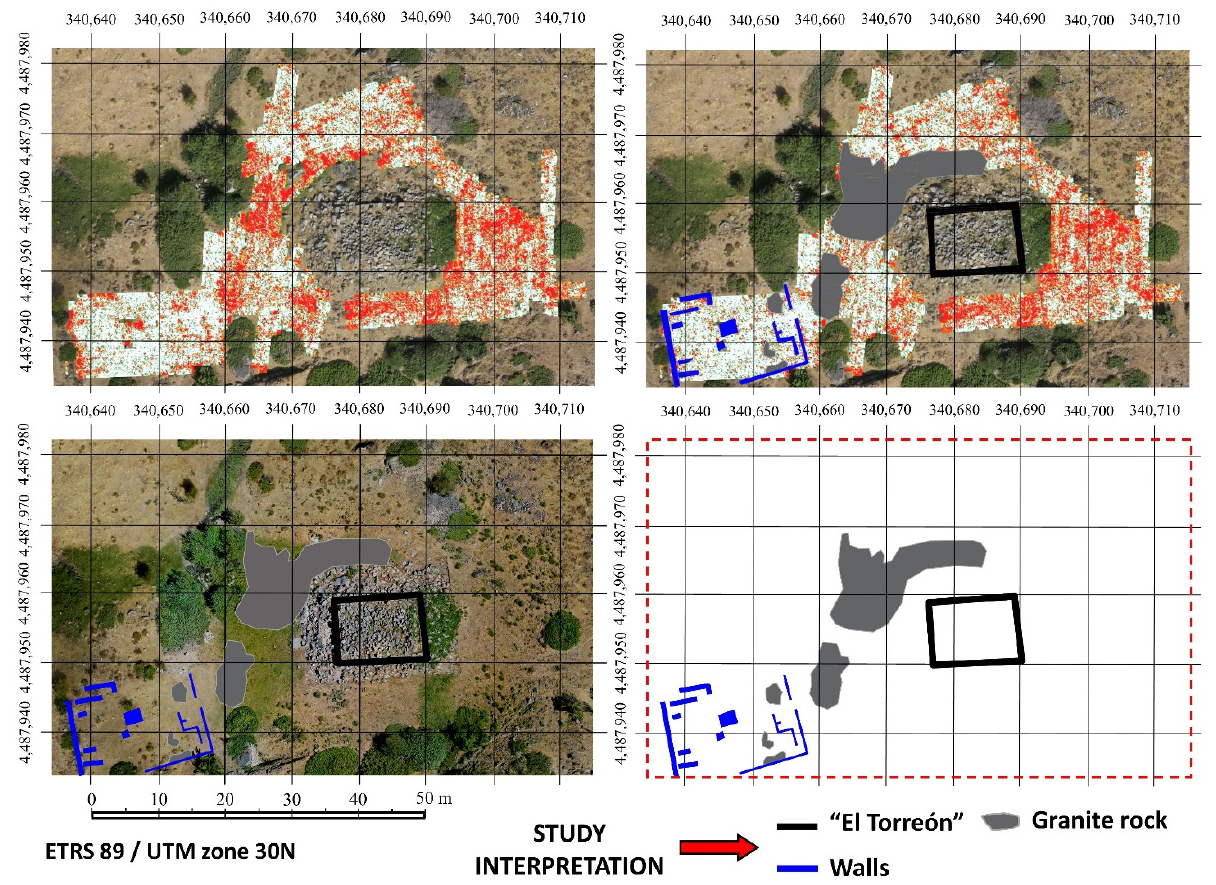
Figure 10. GPR results and interpretative maps.